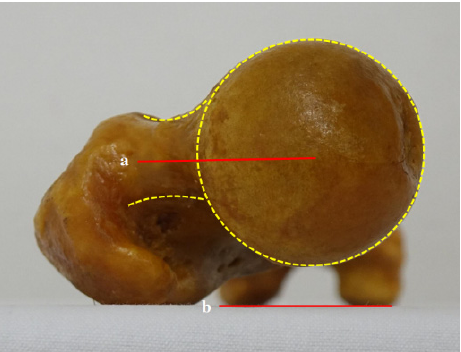
Figure 2. Femoral anteversion angle using the head-to-neck (H-N) line. (a) The connecting line between the center of the head and the center of the neck; (b) connecting line of the posterior border of both femoral condyles.